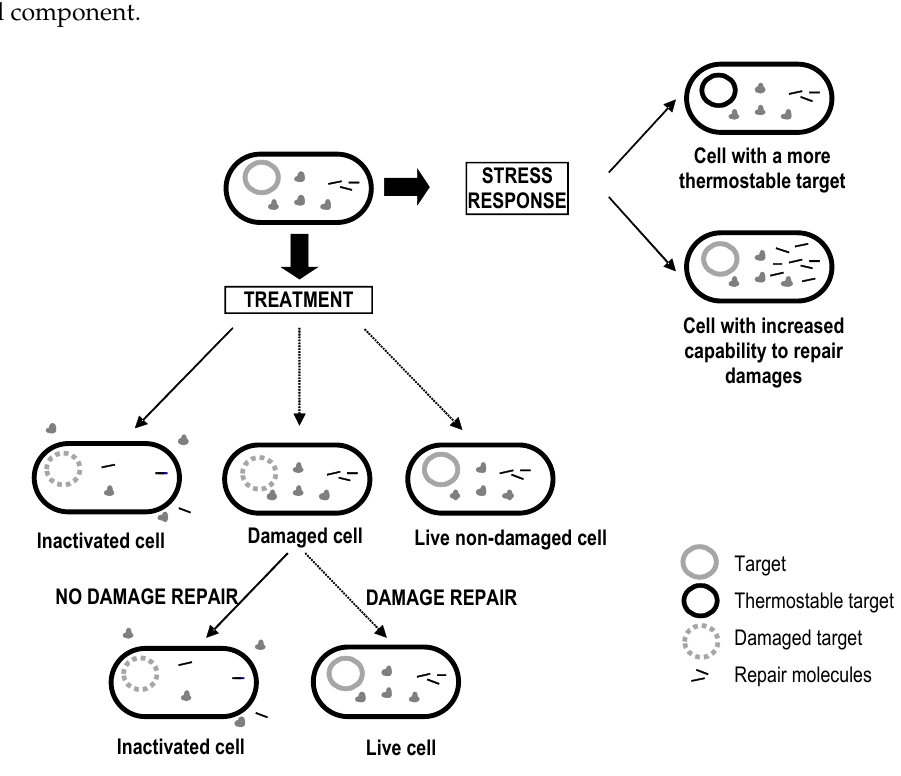
Figure 1. Different scenarios that can determine cellular survival or inactivation upon heat exposure.